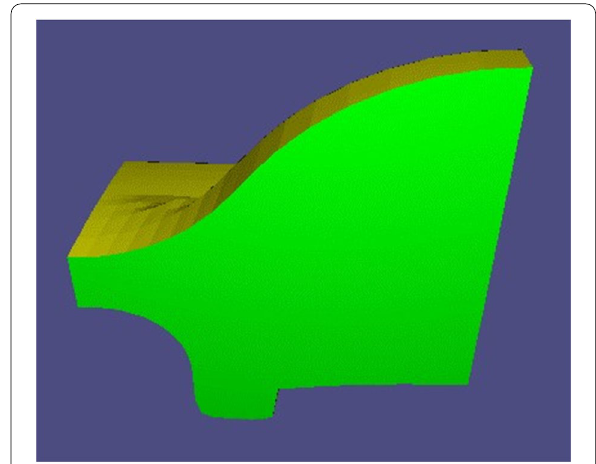
Fig. 6 Setup base of Fandisk